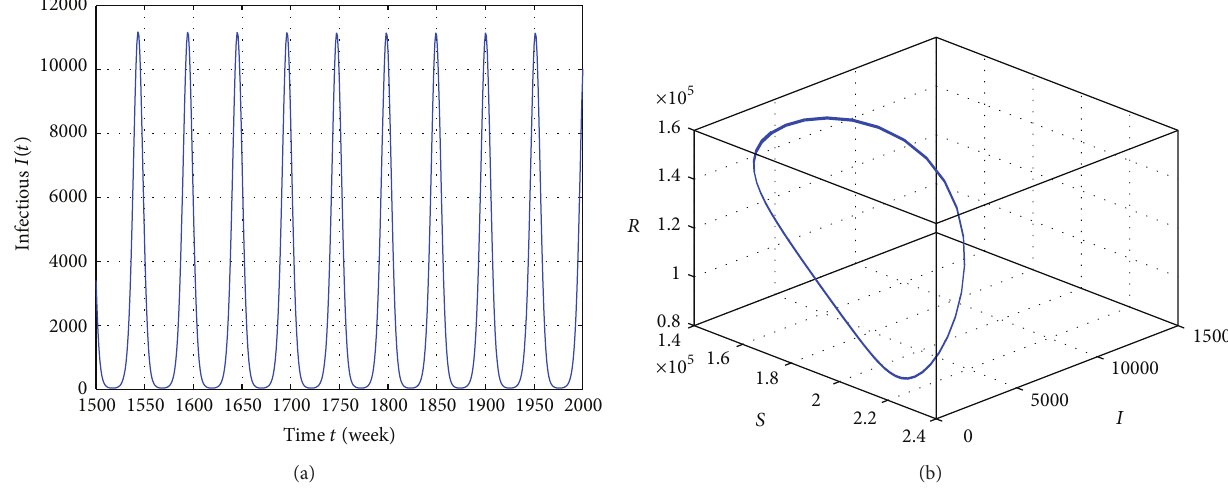
Figure 3: The population dynamics of model (1) with parameters (43). (a) Time series plots; (b) phase portraits (periodic solution).